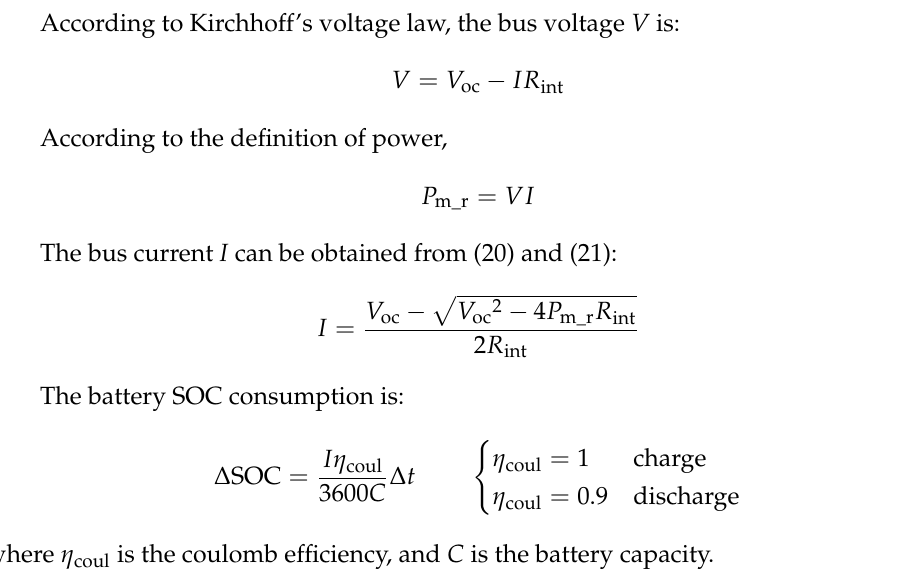
Figure 7. R int model of battery.